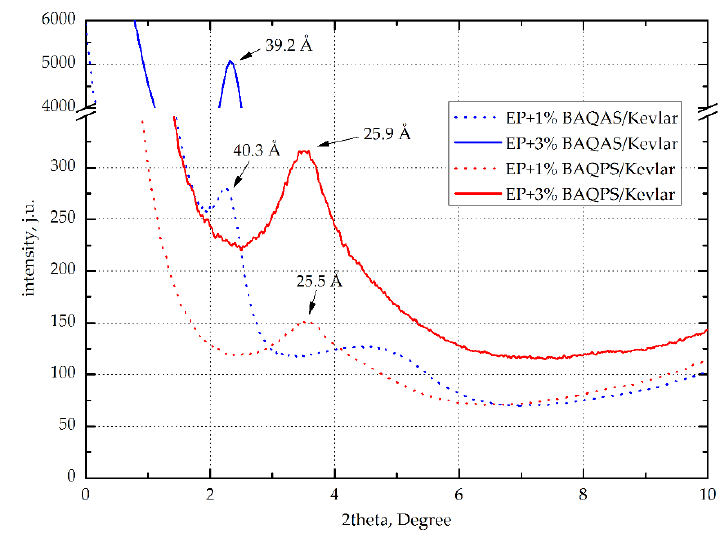
Figure 13. WAXS curves of epoxy/Kevlar composites with modified bentonites.